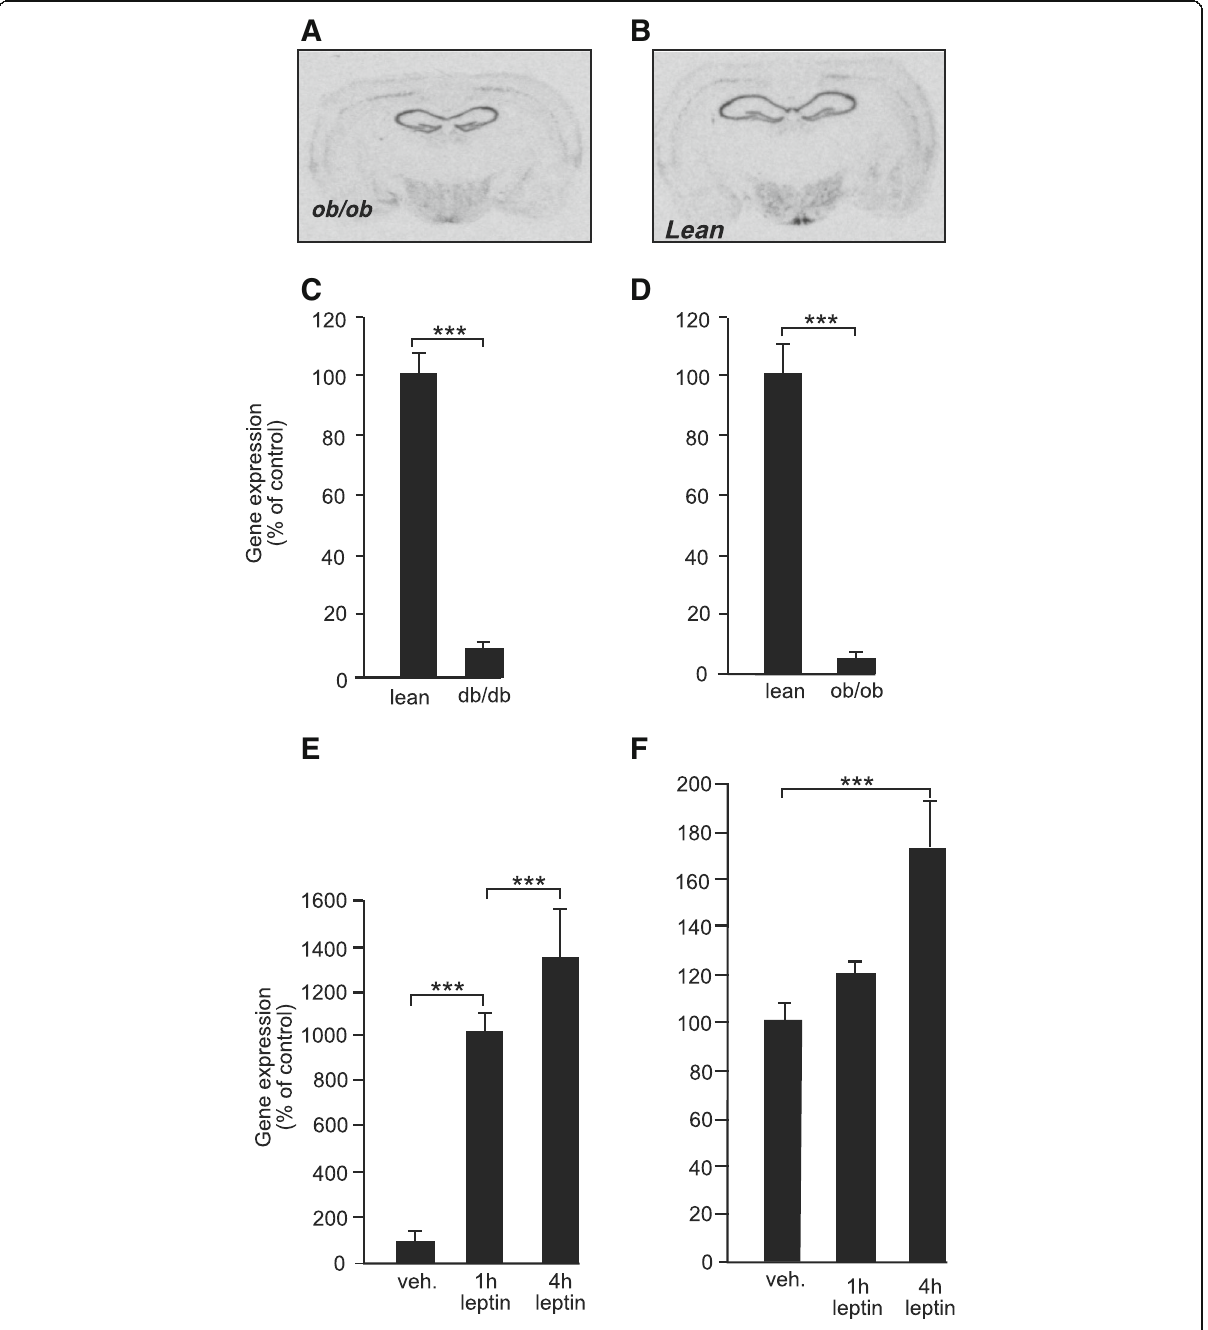
Fig. 4 Representative in situ autoradiographs of mouse brain sections showing serpinA3N expression in a ob/ob mouse on a C57BL/6J background and b lean C57BL/6J mouse. Levels of serpinA3N gene expression in the arcuate nuclei measured by semi-quantitative in situ hybridisation of c db/db on a C57BL/6J background and lean C57BL/6J mice, d ob/ob and lean mice, e ob/ob mice injected with IP vehicle (veh.) or leptin after either 1 or 4 h (h) and f lean mice injected with IP vehicle (veh.) or leptin after either 1 or 4 h (h). *** P < 0.001 ( n =